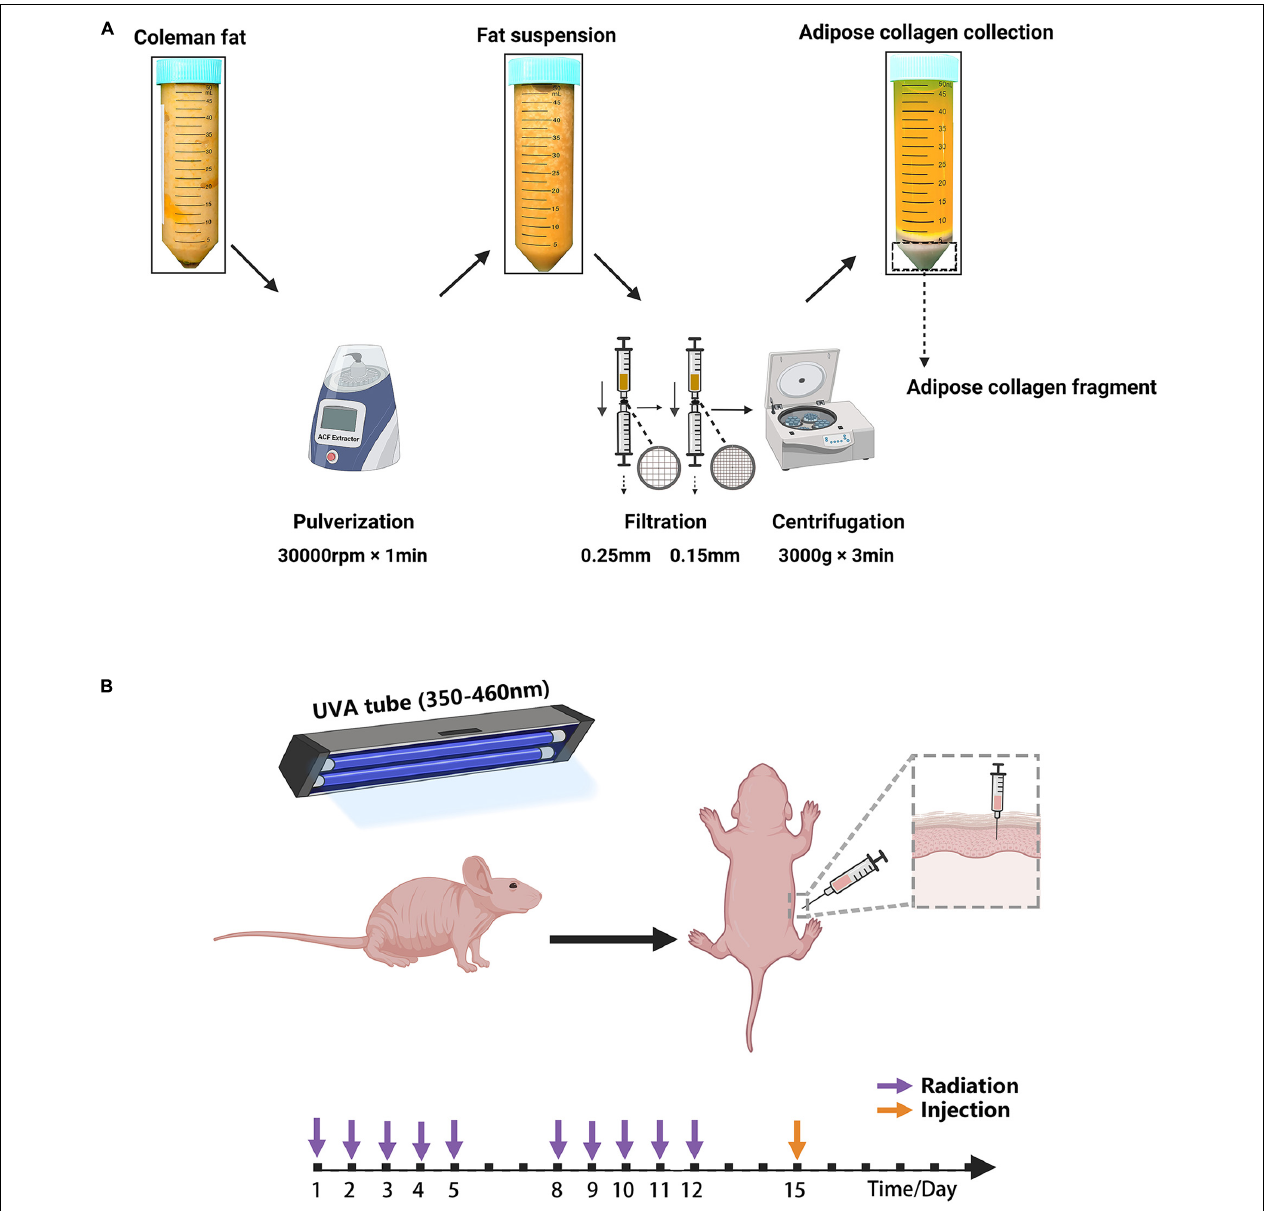
FIGURE 1 | (A) Schematic overview of ACF preparation. (B) Illustration of the animal experiment. The mouse was irradiated by a UVA tube for 2 weeks and then injected with ACF and